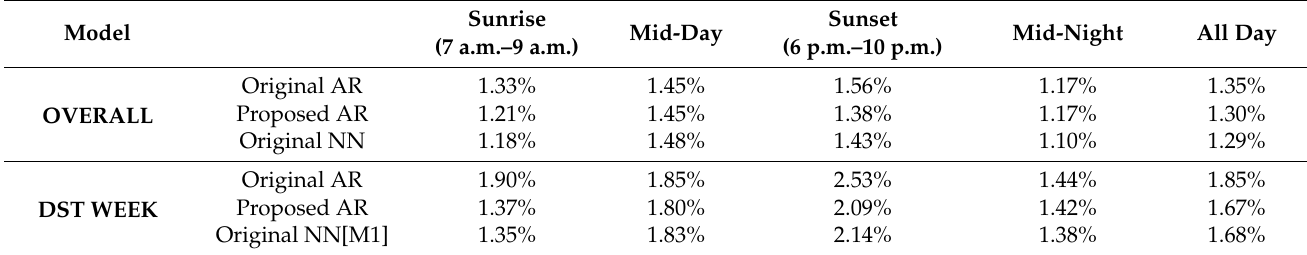
Table 6. Forecasting error for each time of day for 2018.